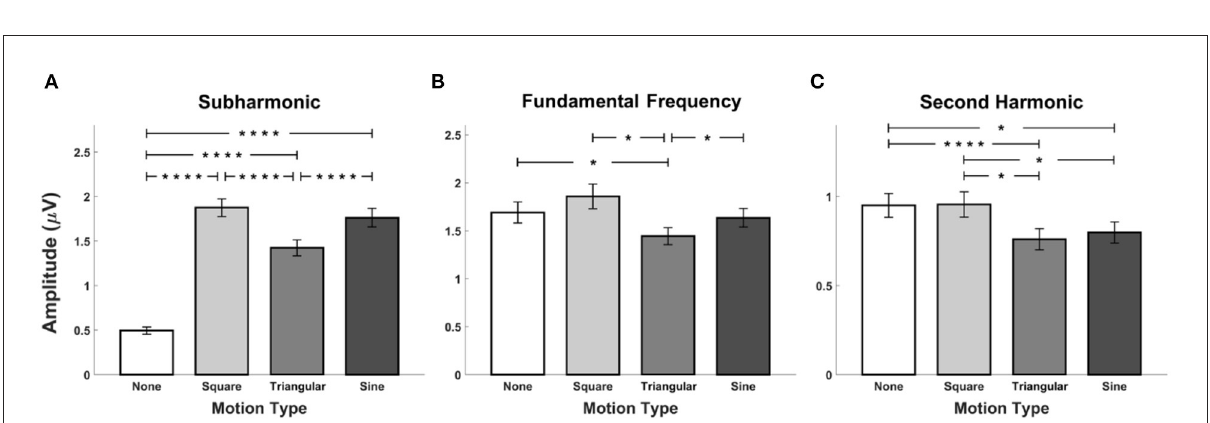
FIGURE8 Grand mean SSVEP amplitudes for PRS-based hybrid visual stimuli averaged across all the participants at (A) the subharmonic frequency, (B) the fundamental frequency, and (C) the second harmonic frequency. Error bars represent the standard errors. Asterisks of * and **** represent FDRs-corrected p < 0.05 and p < 0.001, respectively (Wilcoxon signed-rank test).